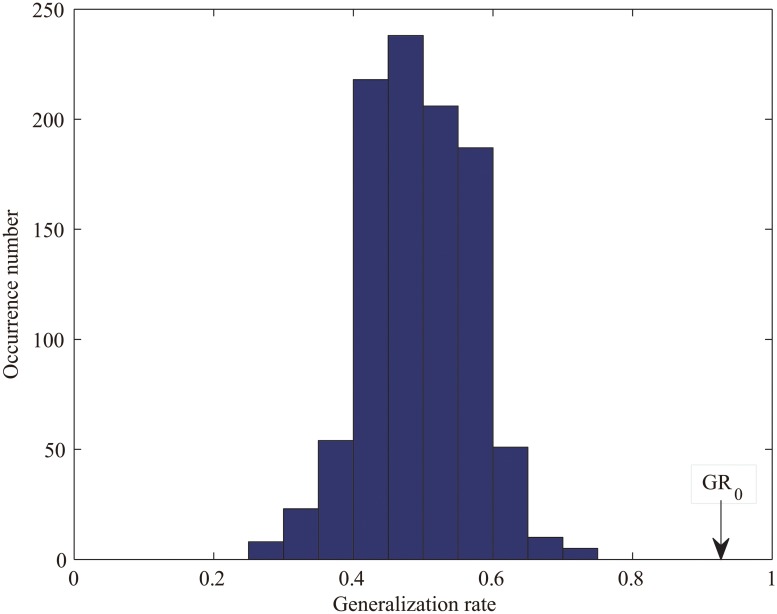
The permutation distribution of the generation rates (1,000 repetitions) when selecting the 150 most discriminating features: the x- and y-labels represent the generalization rate and occurrence number, respectively.
GR
0 is the generation rate obtained using the real class labels.